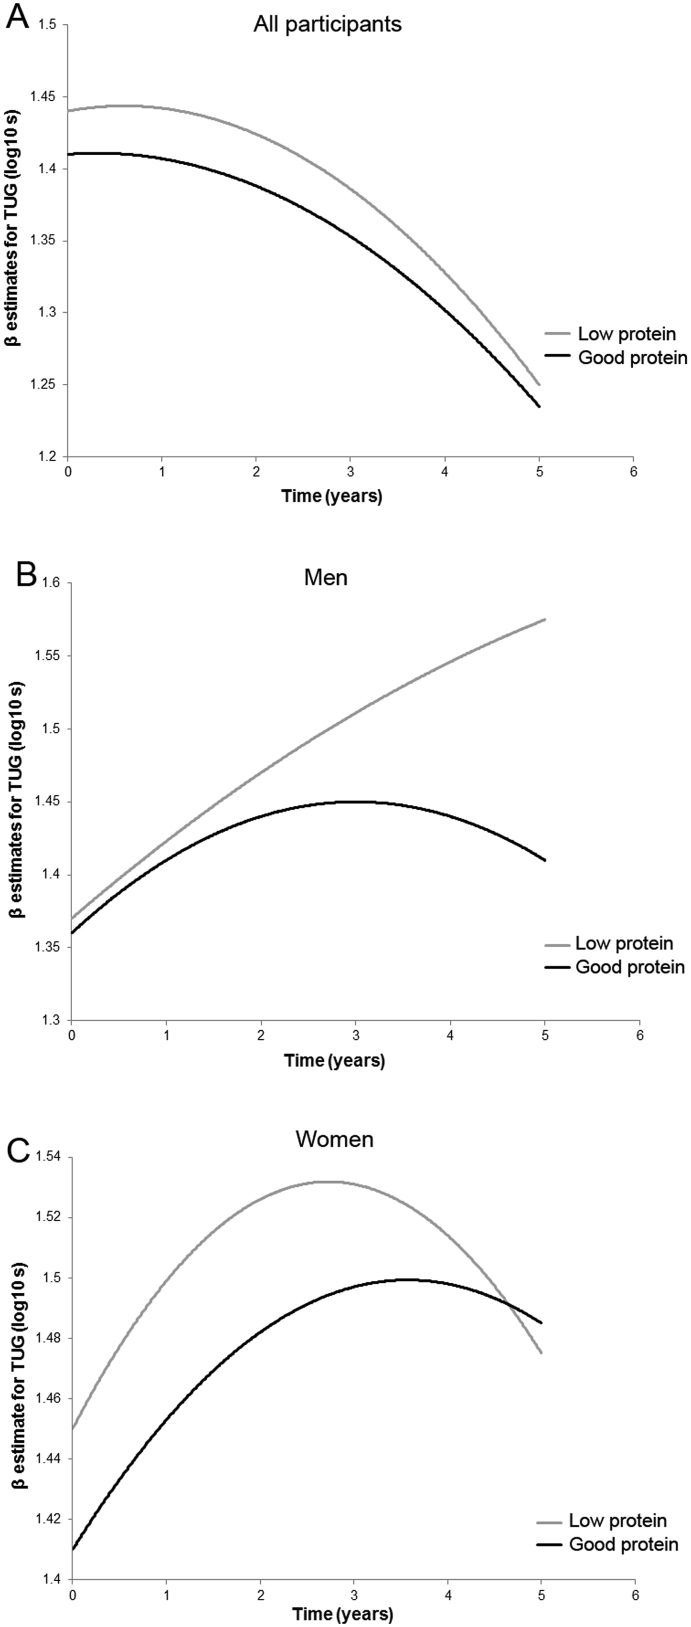
A similar rate of decline in TUG by protein intake. Low protein intake (<1 g/kg aBW/d; grey line) was associated with worse Timed Up-and-Go (TUG) test scores at baseline in all participants (panel A) and in women (panel C), but not in men (panel B) compared with those consuming ≥1 g/kg aBW/d (black lines) of protein. The rate of decline in TUG did not vary by protein intake (panels A, B, and C) over 5 years. The growth curves represent β estimates of the fully adjusted model (Model 3). Greater log10-s indicated worse (slower) TUG performance.